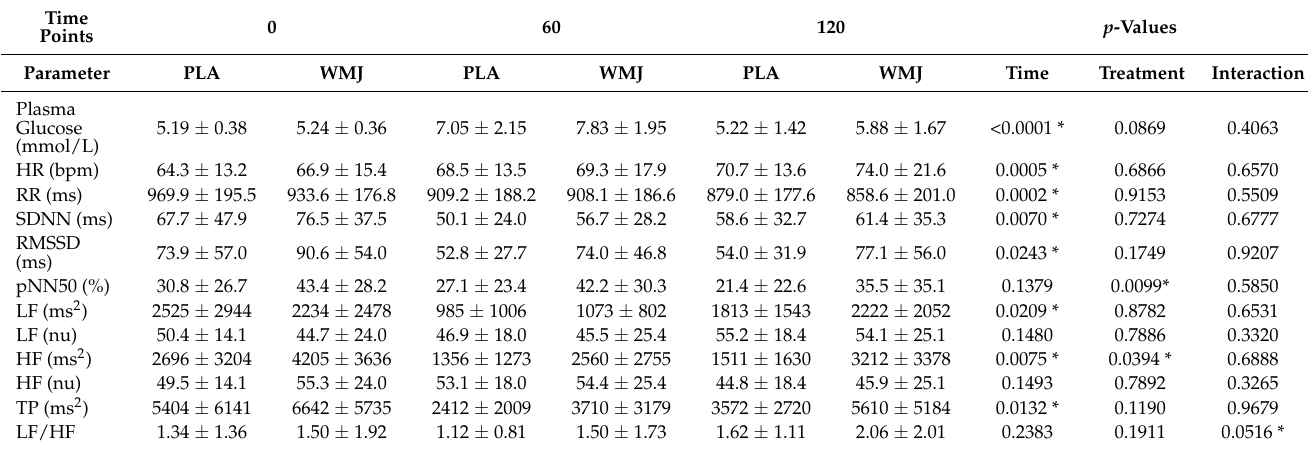
Table 2. Heart rate variability response during the oral glucose challenge.